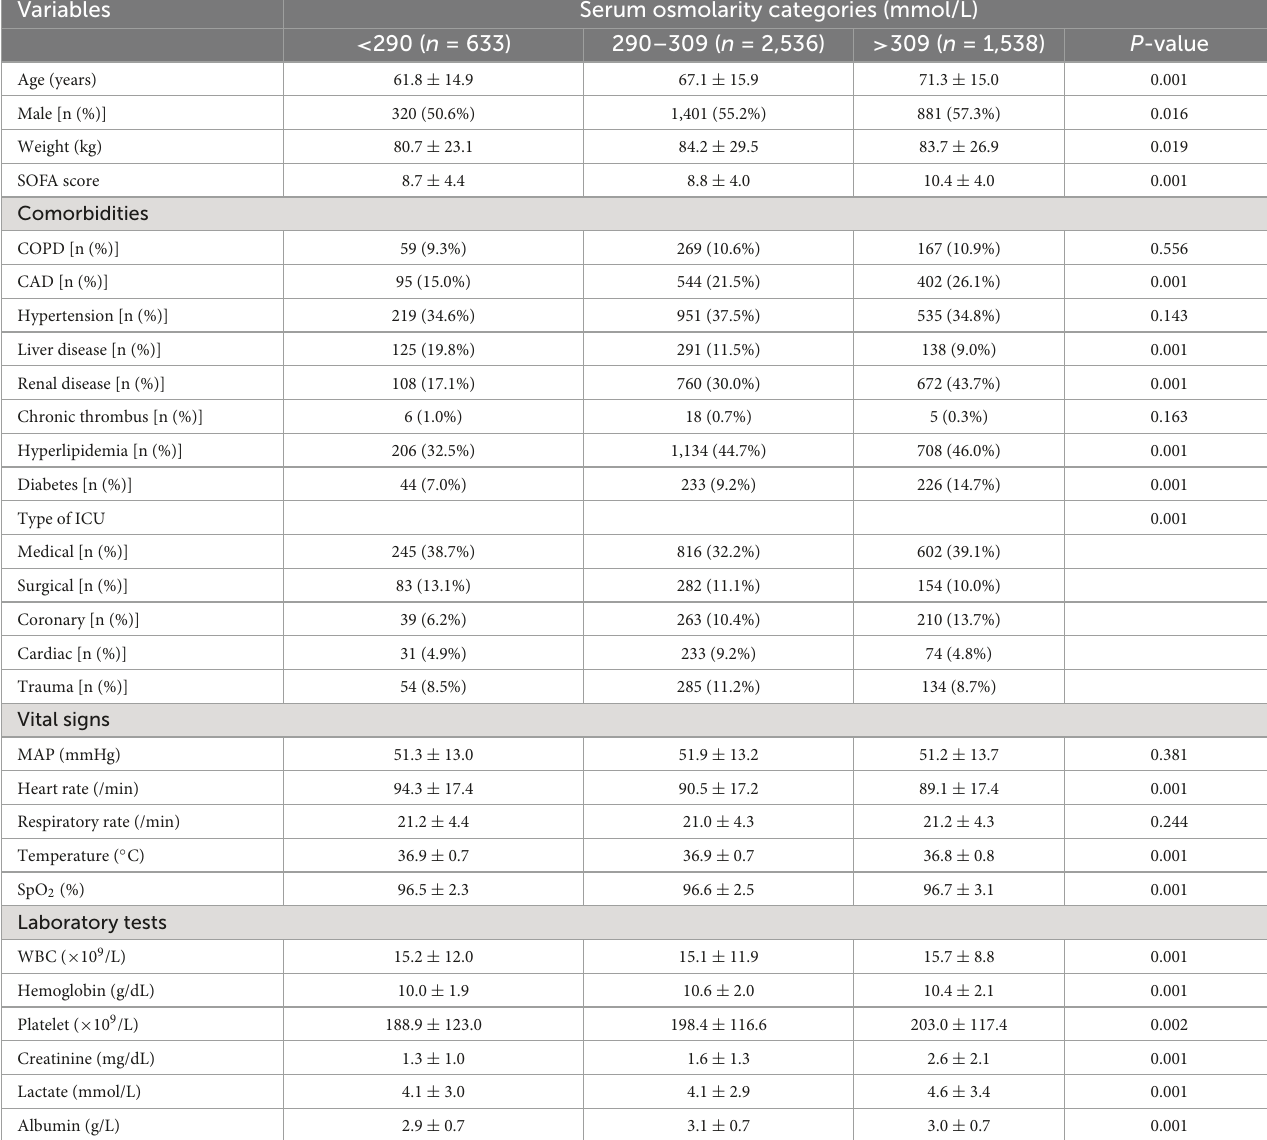
TABLE 1 Comparison of baseline characteristics between different serum osmolarity groups.